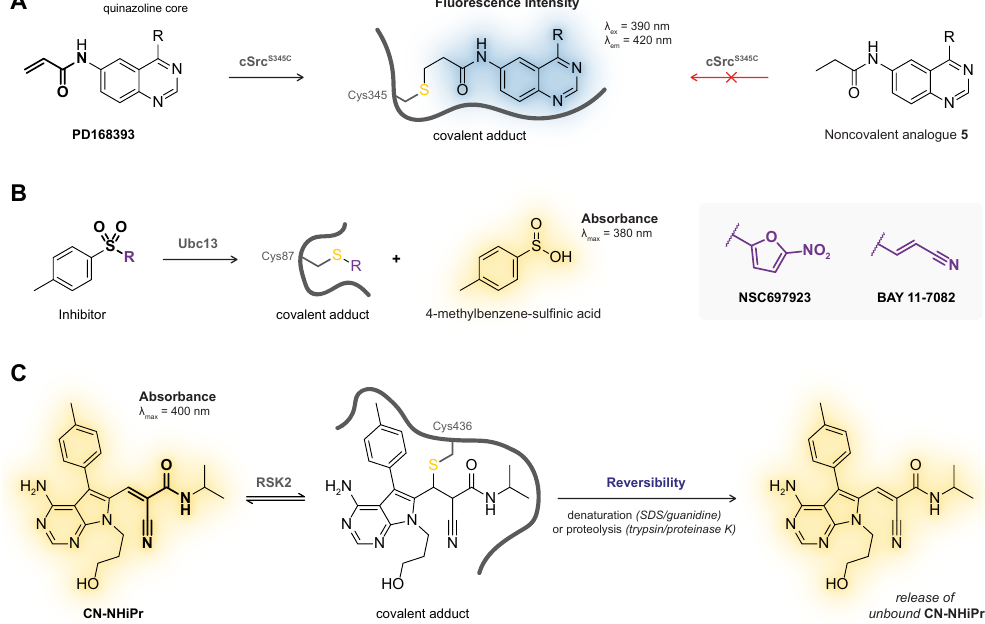
Figure 7. Direct detection of changes in intrinsic spectroscopic properties upon covalent thiol addition. ( A ) Thiol addition increases intrinsic fluorescence intensity of quinazoline and quinoline cores with an attached conjugated Michael acceptor [142]. Detection of increased fluorescence intensity upon adduct formation for irreversible covalent inhibitor PD168393 with cSrc S345C but not for the noncovalent analogue. ( B ) Release of 4-methylbenzene-sulfinic acid results in a detectable absorption increase upon covalent adduct formation of inhibitors NSC697923 and BAY 11-7082 with Ubc13 WT [143]. ( C ) Intrinsic absorption in the UV-visible spectrum of N -isopropyl cyanoacrylamide CN-NHiPr decreases upon nucleophilic thiol addition [54]. The reappearance of signal upon protein denaturation or proteolysis-induced inhibitor dissociation is indicative of a reversible covalent binding